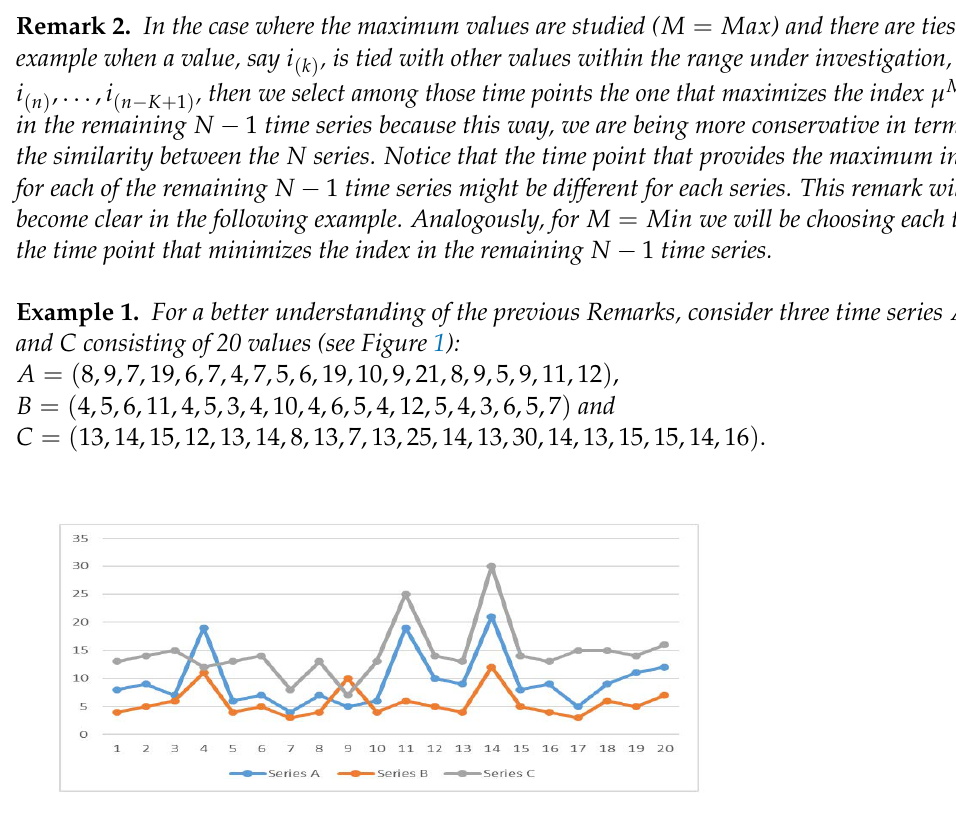
Figure 1. Time series A, B and C.